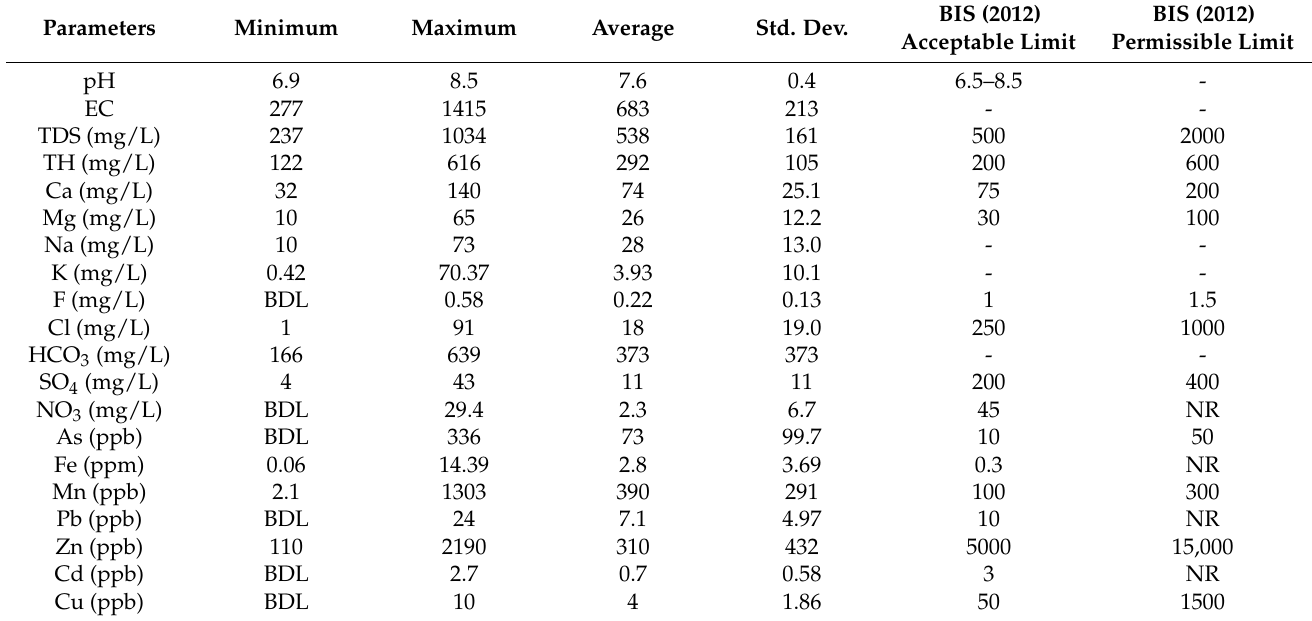
Table 1. Statistical summary of groundwater quality in the study